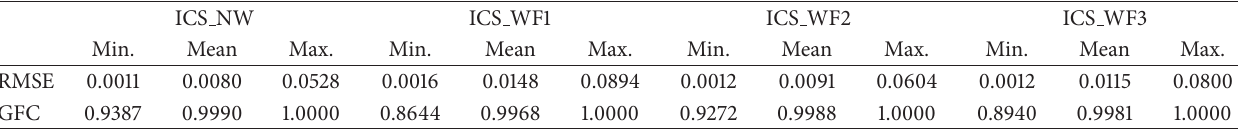
Table 2: Spectral representing accuracy comparison of the four ICSs with odd and even chips of Munsell as training and testing samples,